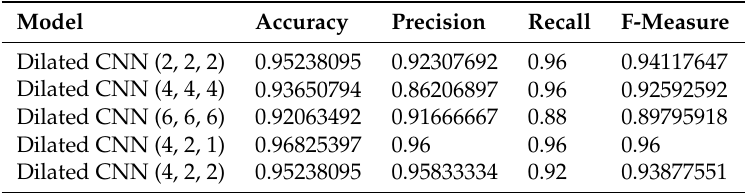
Table 4. Comparing Accuracy, Precision, Racall and F-Measure across different configurations of dilation rates for the convolution